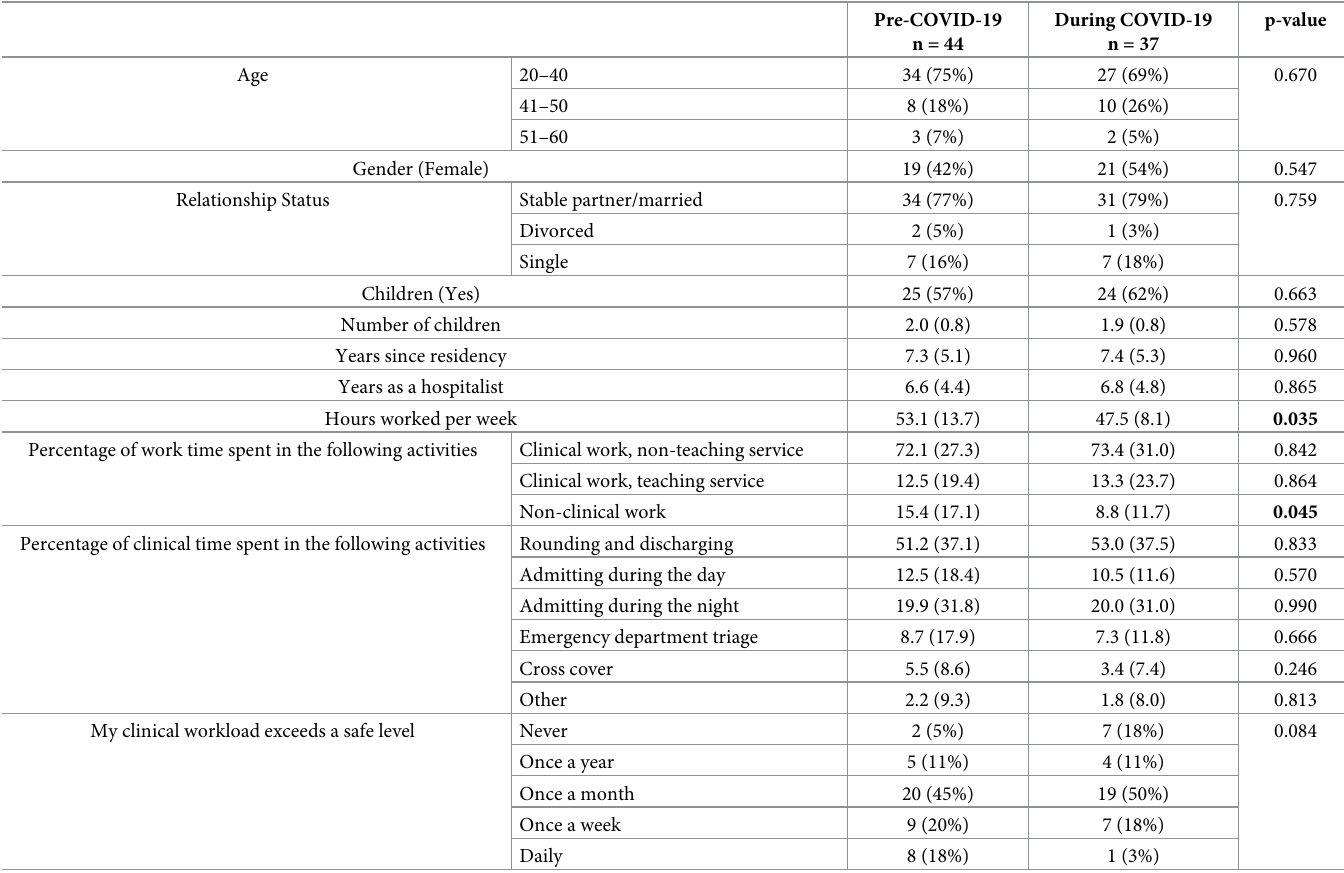
Table 1. Characteristics of